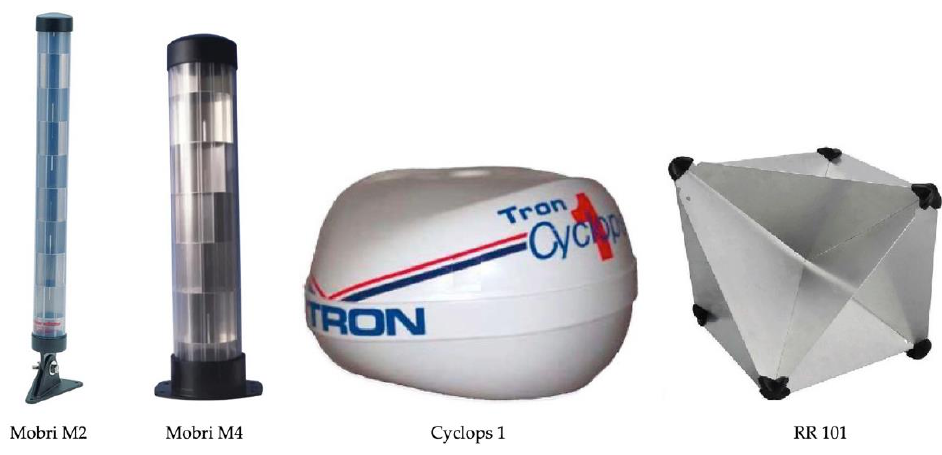
Figure 2. Types of tested passive radar reflectors.